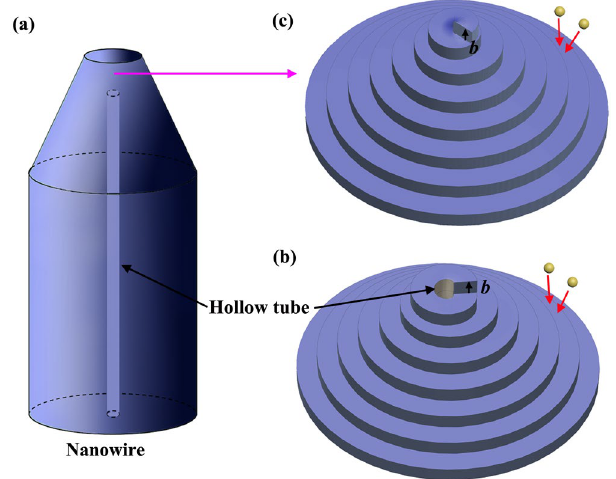
Figure 5. Schematic diagram of the growth process for α -Al 2 O 3 nanowires. ( a ) The structure of α -Al 2 O 3 nanowires; ( b ) the formation of the hollow tube structure in α -Al 2 O 3 nanowires by axial screw dislocations, where the b is shown; ( c ) the formation of the solid structure in α -Al 2 O 3 nanowires by axial screw dislocations, where the b is